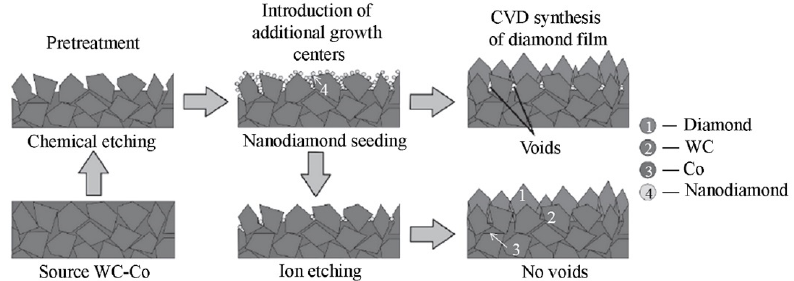
Figure 1. Schematic diagram of the production of diamond films on WC-Co alloy [6].